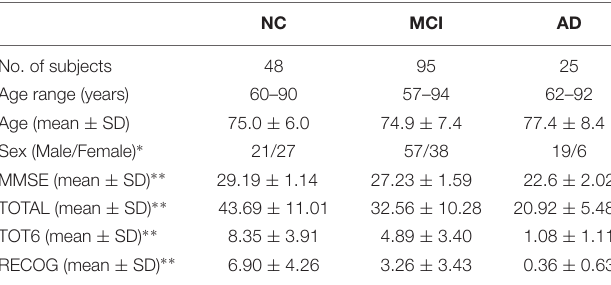
TABLE 1 | Demographic information of study